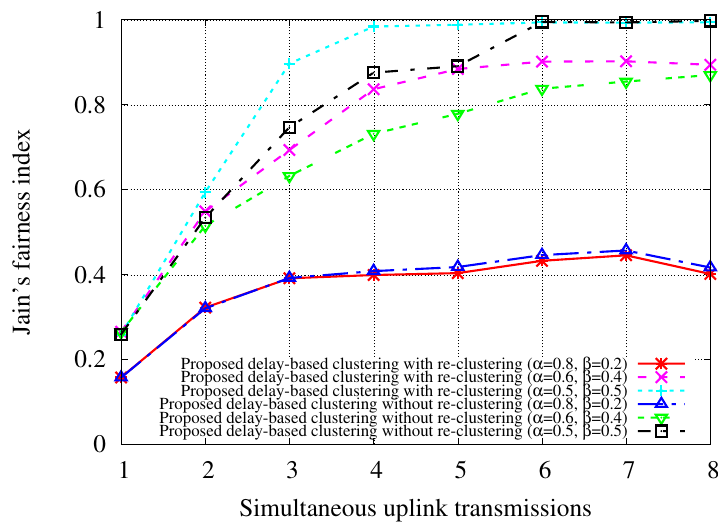
Figure 10. Fairness performance (MCS of 40% stations changes, λ =